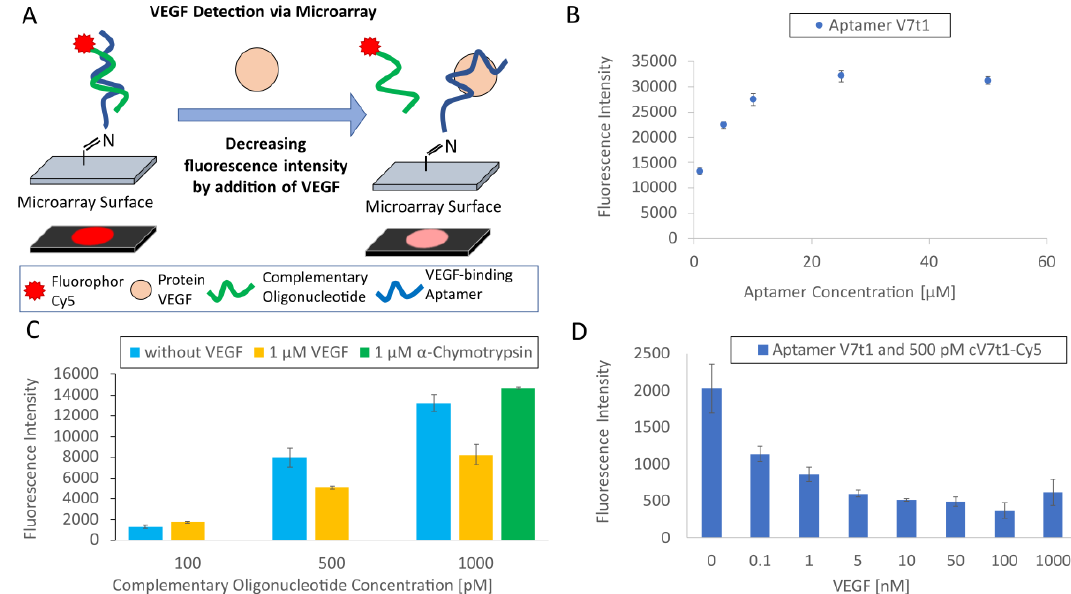
Figure 4 Figure 4. Transfer of the TID assay for VEGF detection to the microarray format. ( A ) Schematic The fluorescence signal of